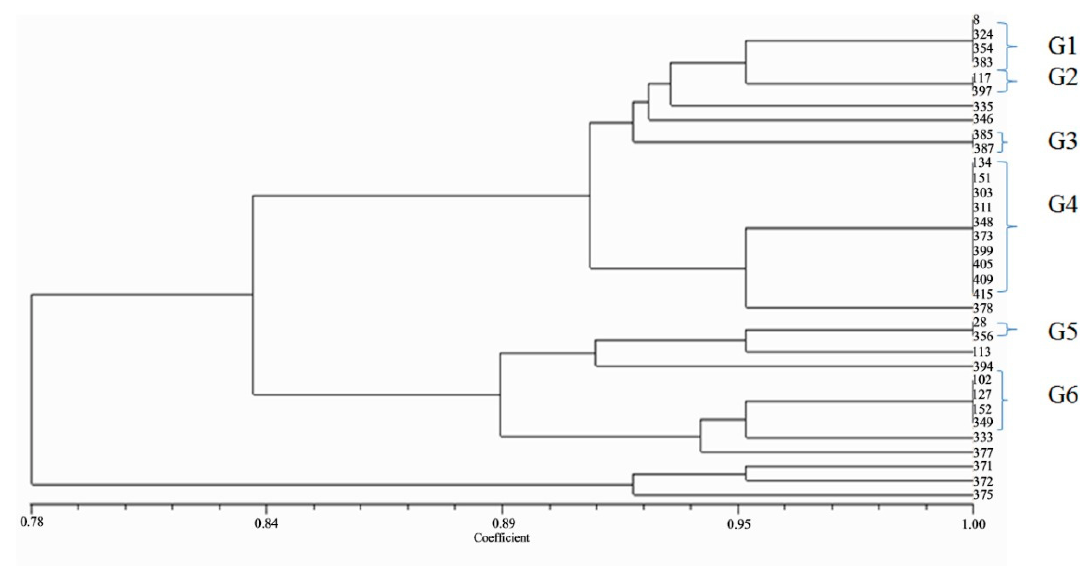
Figure 4. ERIC-PCR dendrogram for 34 isolates harboring bla OXA-48-like encoding genes; implemented using NTSYS 2.01 software. The investigated isolates were divided into 16 genotypes. Among them, there were many groups; each represented genetic relatedness. G1(Group 1; isolates: 8, 324, 354, and 383); G2 (Group 2; isolates: 117 and 397); G3 (Group 3; isolates: 385 and 387); G4 (Group 4; isolates: 134, 151, 303, 311, 348, 373, 399, 405, 409, and 415); G5 (Group 5; isolates: 28 and 356), and G6 (Group 6; isolates: 102, 127, 152, and 349). The remaining 10 isolates represent unique patterns (isolates: 113, 333, 335, 346, 371, 372, 375, 377, 378, and 394).